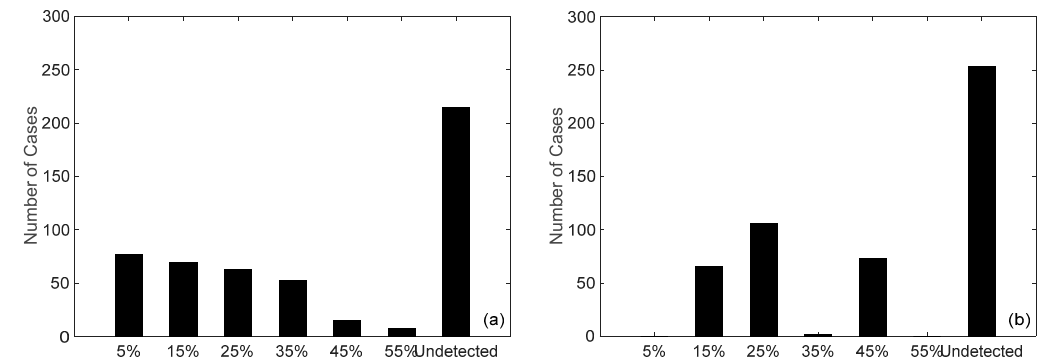
Figure 11. Delayed leak detection time for the 500 cases with random uncertainties under steady state conditions in systems where: ( a ) R = 0.49; and ( b ) R = 2.20.